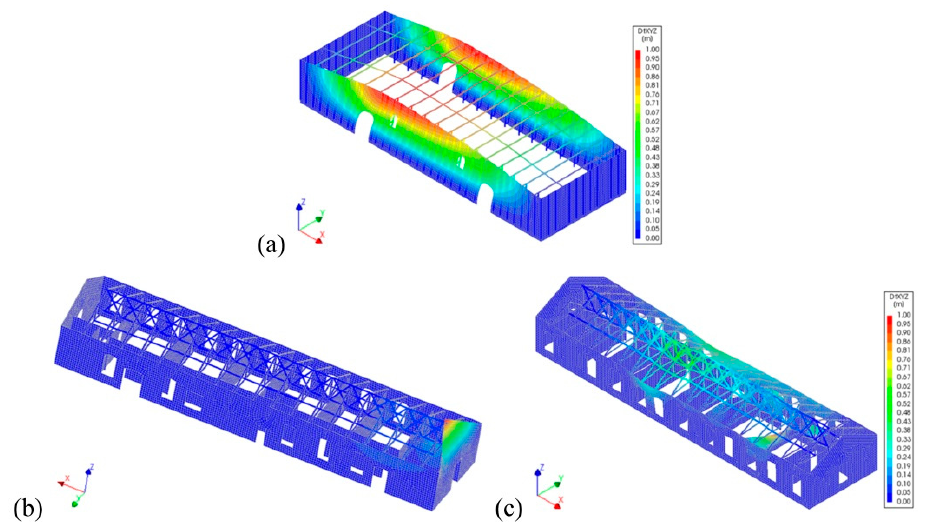
Table 3. Eigenvalue comparison of the Otaru warehouse.